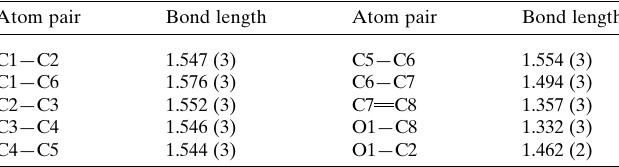
Table 1 Bond lengths (A˚ ) in the central eight-membered ring of the molecule.